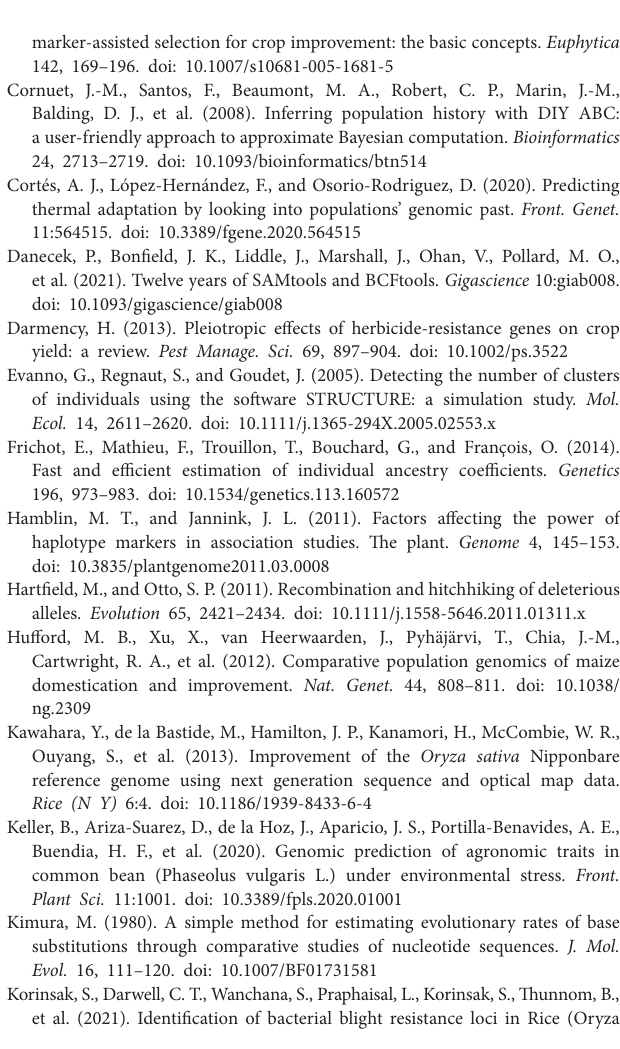
genome chromosomes ( cf. Table 2 in main text). See Supplementary Table S5